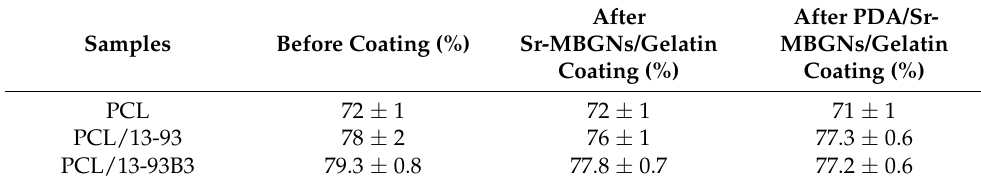
Samples Before Coating